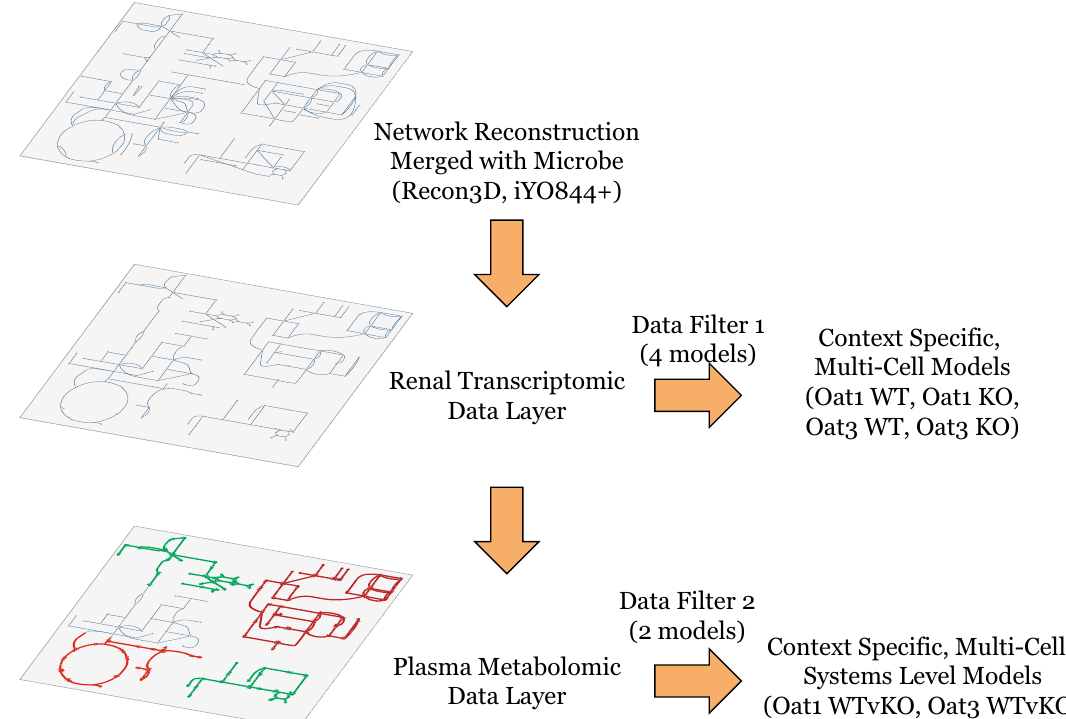
Figure 2. Schematic of study design. Shown here is an outline of the workflow to generate the context-specific models for the OAT1 and OAT3 “transcriptome model” and “transcriptome plus metabolome” models. As described in Methods, a human metabolic reconstruction (Recon3D) was merged with a representative microbiome metabolic reconstruction. The first tier (‘Data Filter 1’) involves generation of context-specific models for OAT1 and OAT3 WT and KO mice using renal transcriptomic data. The second tier (‘Data Filter 2’) uses targeted plasma metabolomic data to generate sets of WT versus KO comparison models. Since the plasma metabolome includes inter-organ interactions (uptake, elimination, and metabolism) across all organs in the body, alterations (synthesis and degradation) due to non-renal metabolism can be inferred using independently defined metabolic objectives (see “Methods” and main